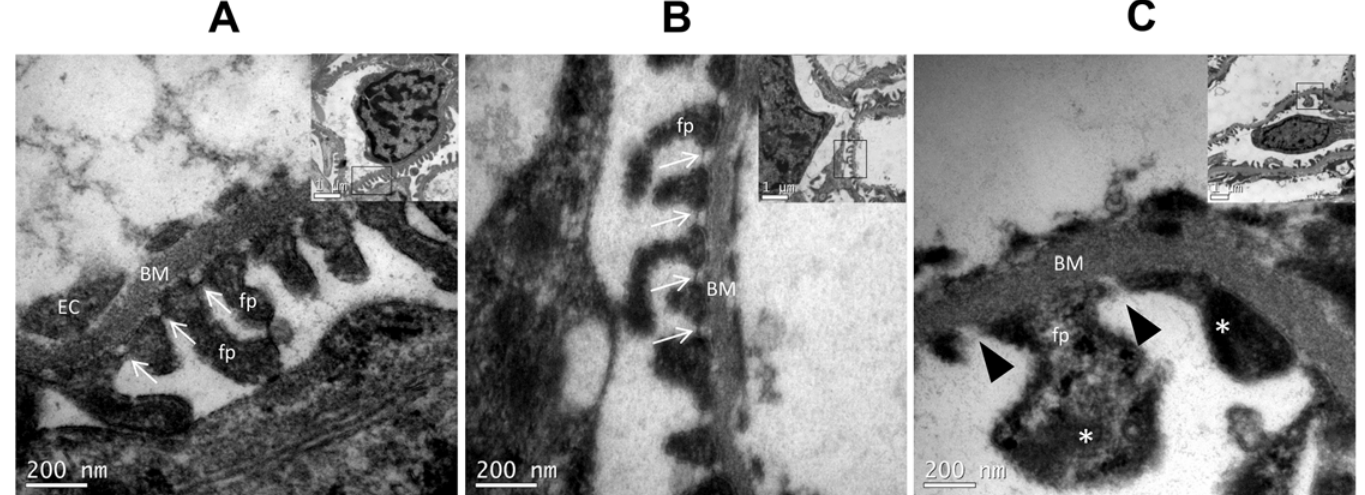
Fig 4. Glomeruli ultrastructural examination. Transmission electron microscopy images show the ultrastructural pedicels (fp) and slit diaphragms (SD, arrows) from the podocytes. Images A and B show the normal podocyte structure from Normal and Low salt group respectively, with SD integrity. Image C shows that the high salt group has lost the morphological integrity of its podocyte processes (fusion/effacement * ) along with the slit diaphragms (black arrow head). BM, basement membrane; EC, endothelial cell.